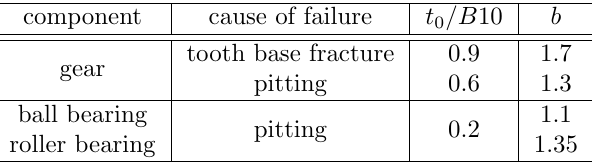
Table 1: Weibull parameters of failure distributions,